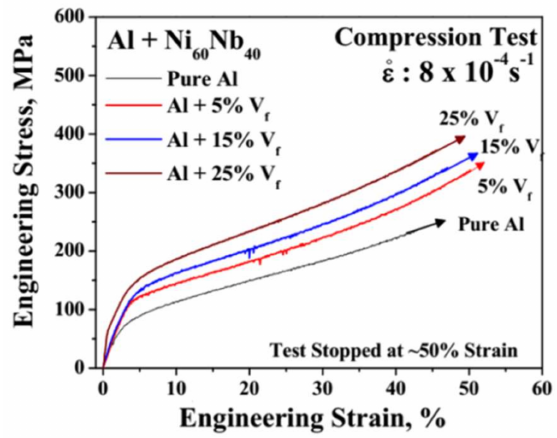
Figure 11. Compression properties of pure aluminum reinforced with Ni 60 Nb 40 (atomic pct.) amorphous alloy powder, synthesized by bi-directional microwave sintering [34]. (© 2013, Elsevier. Used with